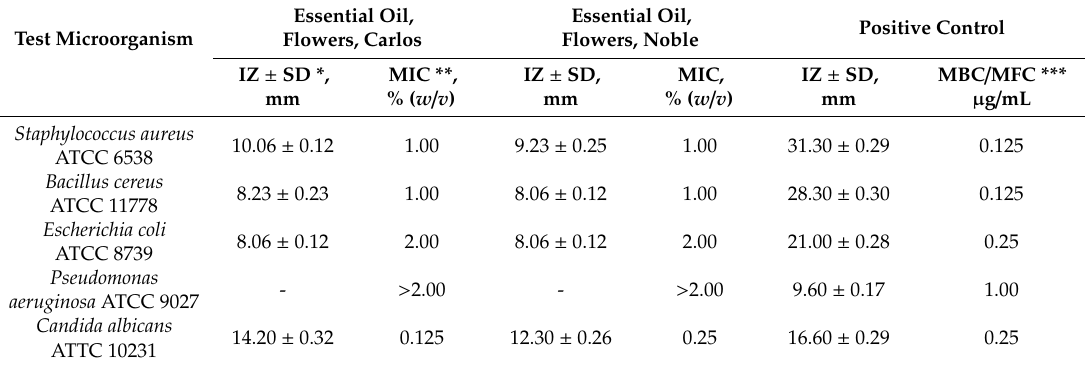
Table 3. Antimicrobial activities of essential oils and hydrosols from two M. rotundifolia (Michx.) Small.